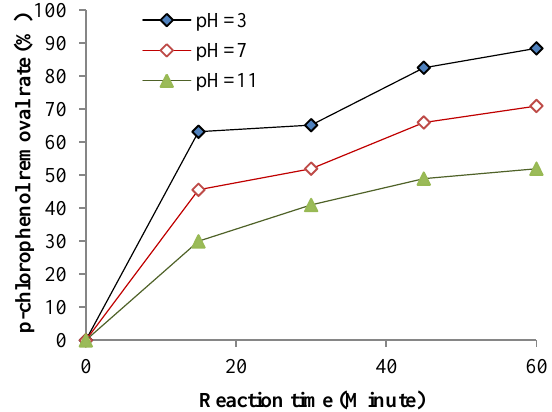
Figure 3. Influence of initial zerovalent iron (ZVI) dosage on the degradation of p-chlorophenol Initial experiment conditions: pH = 3, persulfate = 2 mM, p- chlorophenol = 0.44